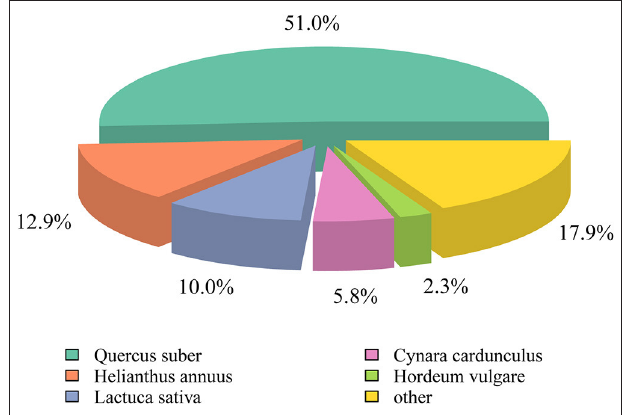
FIGURE 2 | The percentage (%) of C. rhombifolium unigenes hits the species in the Nr